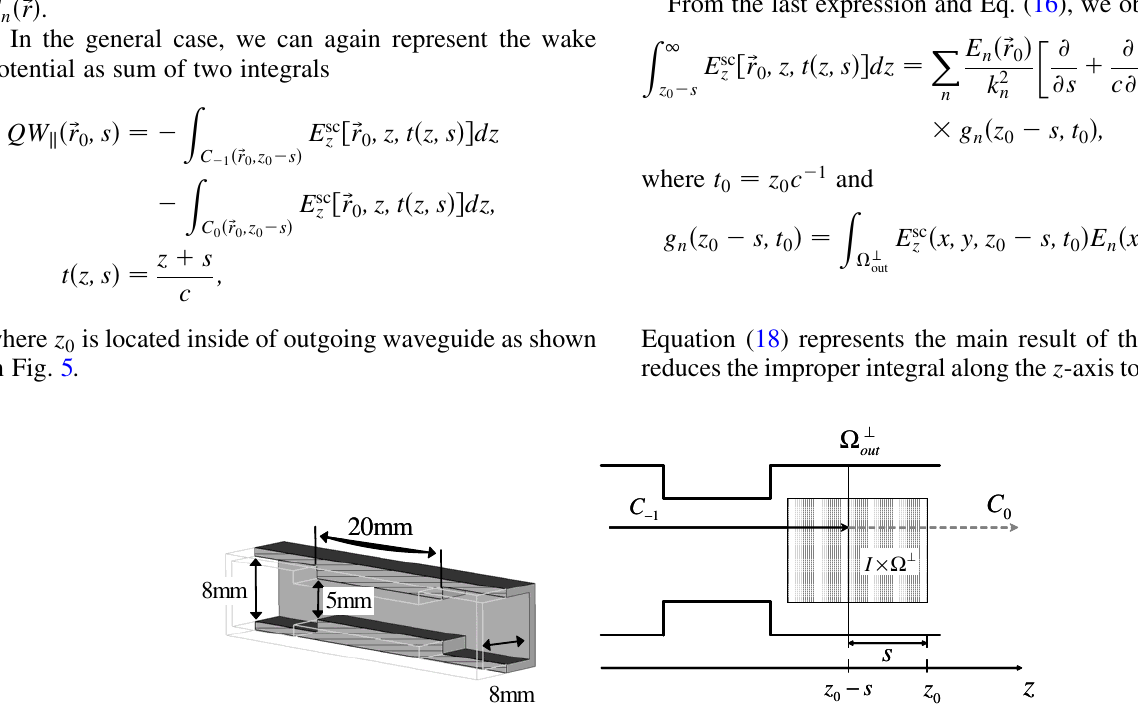
for indirect integration out